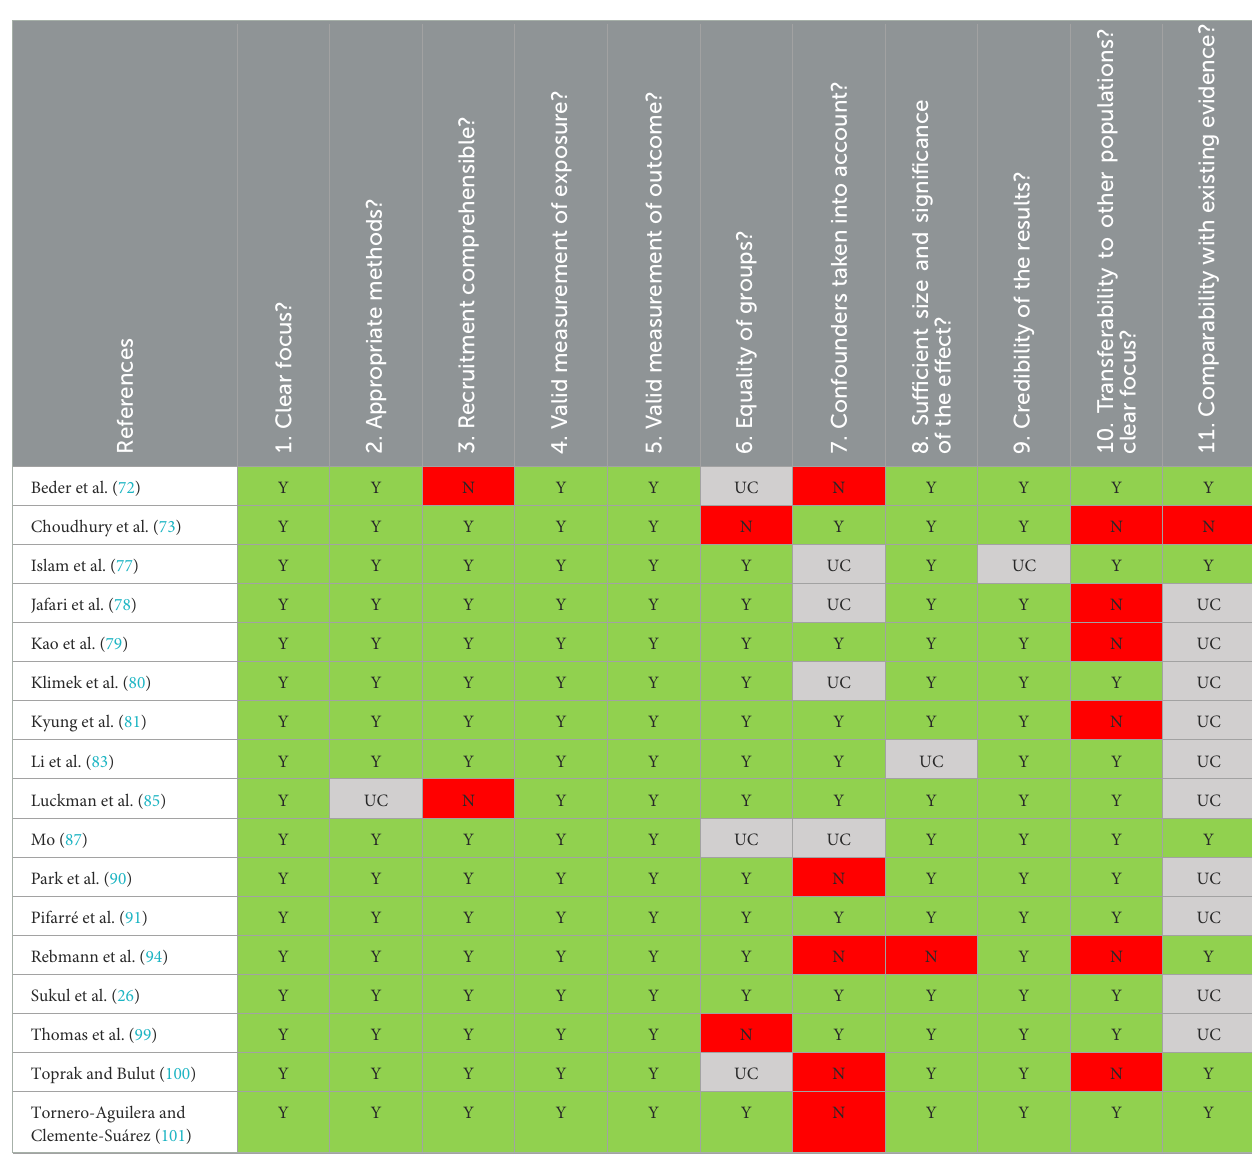
TABLE 2C Quality appraisal of the observational studies (CASP